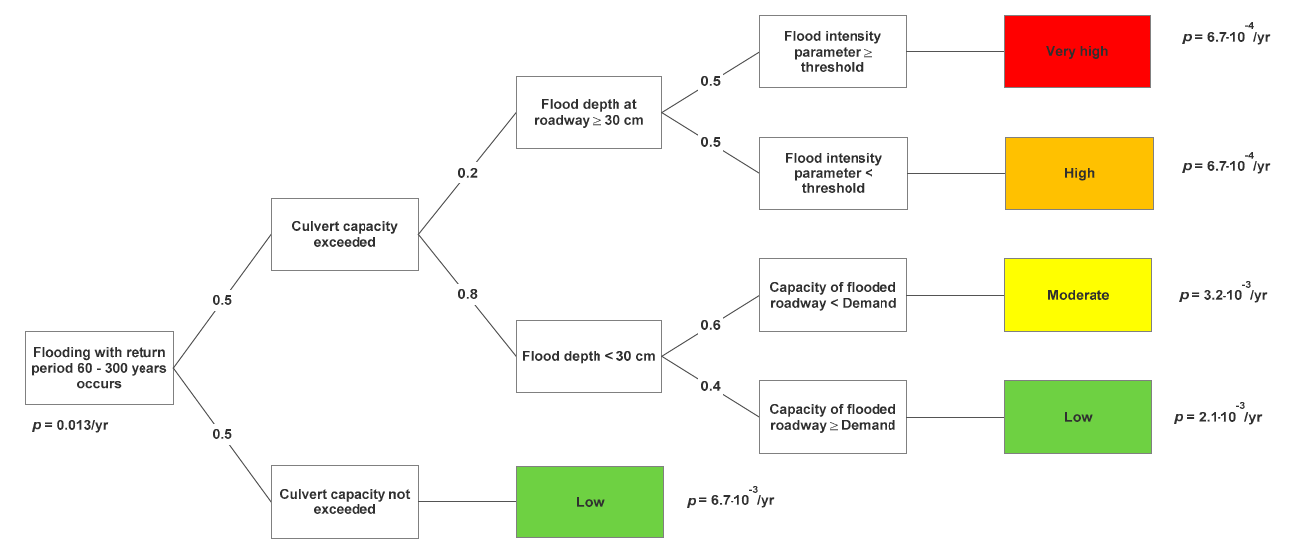
Figure 8. Quantitative assessment of the probability for different consequence classes. Table 8 indicates which considerations should be done and the reasoning behind the choice of event probabilities in Figure 8. Table 8. Definition of events and considerations for assessment of event probabilities.